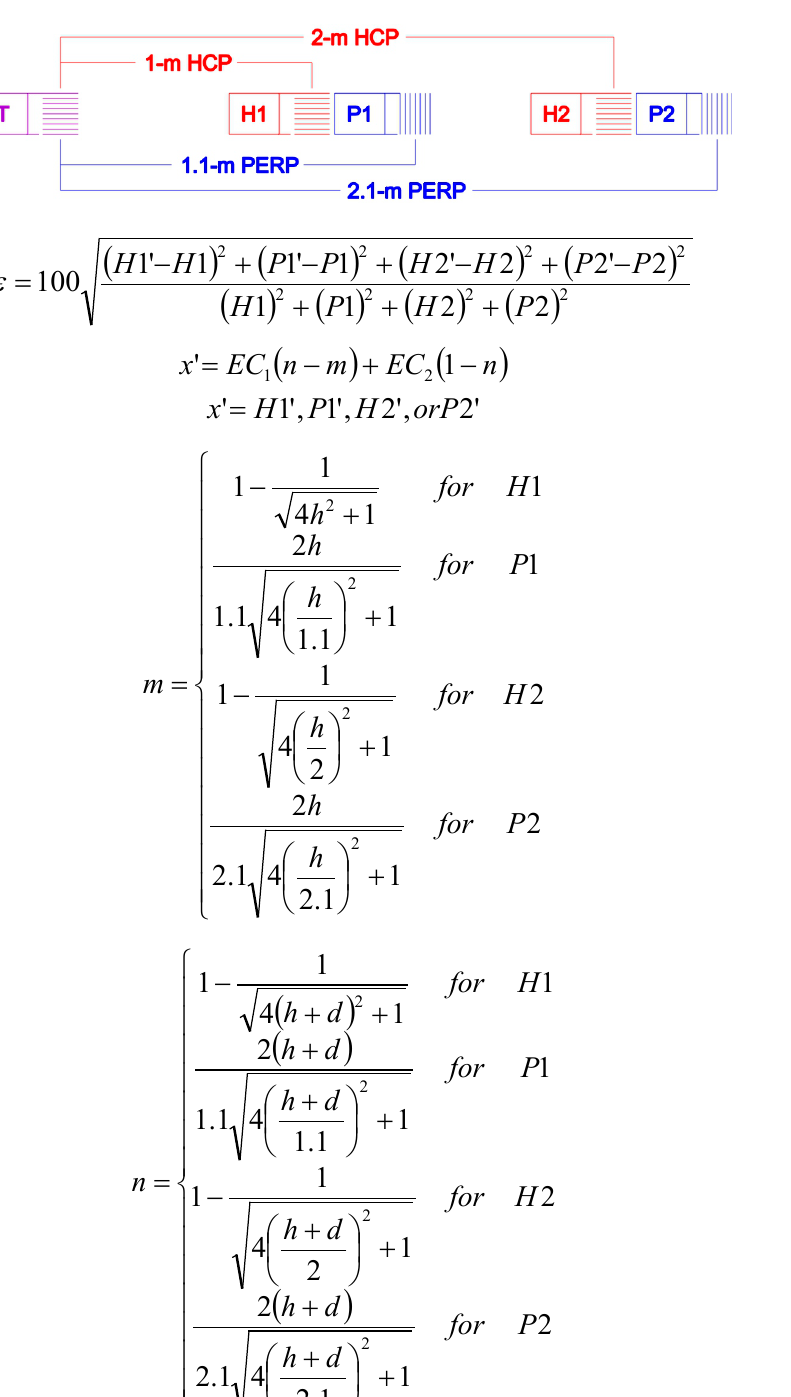
Figure 6. Schematic overview of the DUALEM-21S sensor with the transmitting coil (T) and four receiving coils (two in a horizontal coplanar (HCP) and two in a perpendicular (PERP) loop orientation in relationship to the transmitting coil)